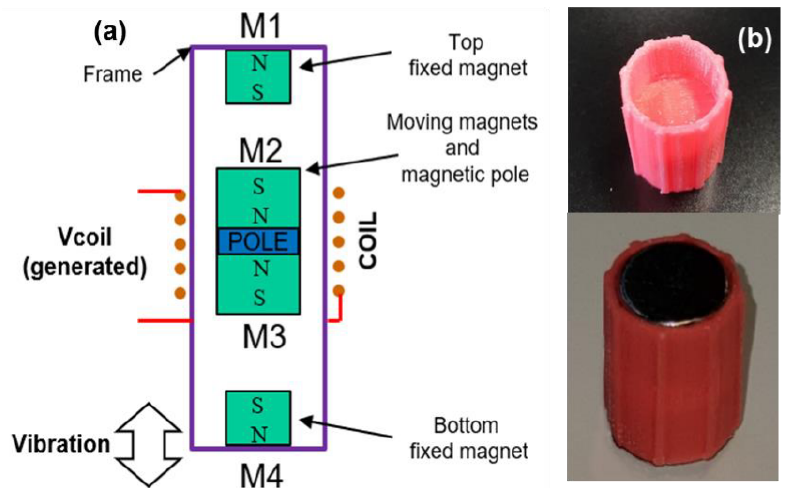
Figure 3. ( a ) Schematic of a straight tube harvester with magnetic springs [43], ( b ) printed harvester made of PLA with and without magnets